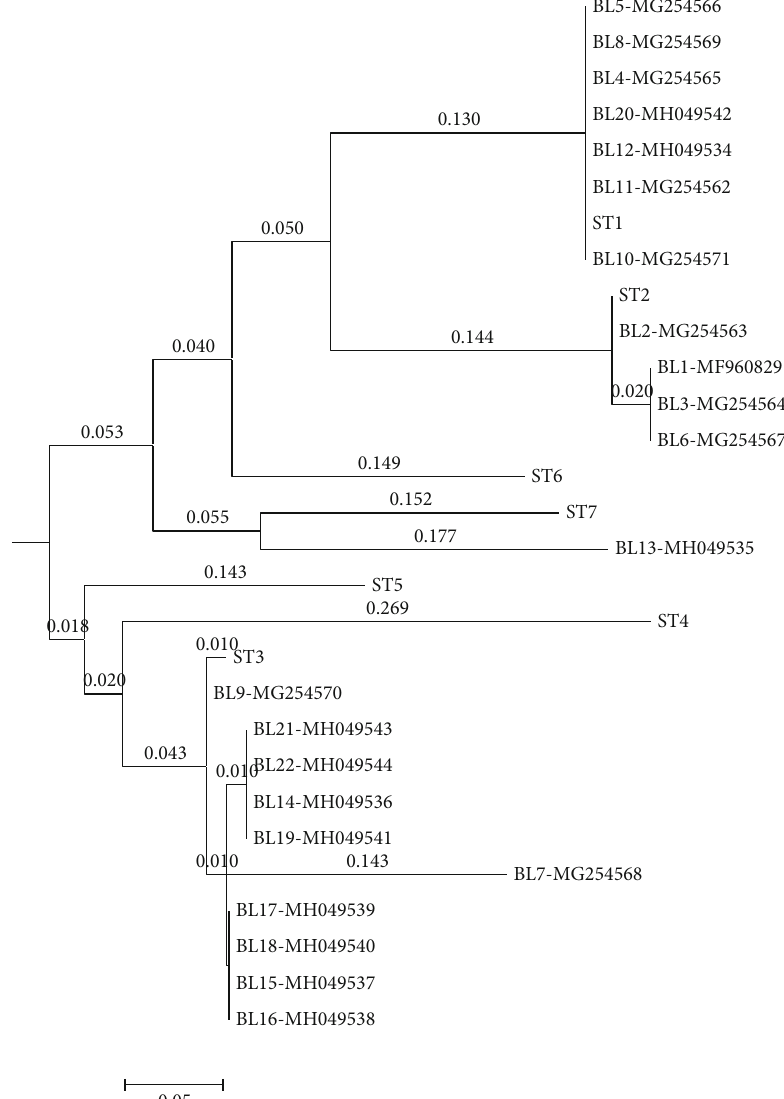
Figure 3: Phylogenetic tree of the SSU-rDNA gene sequences of Blastocystis specimens. The phylogenetic tree was inferred using the neighbor-joining